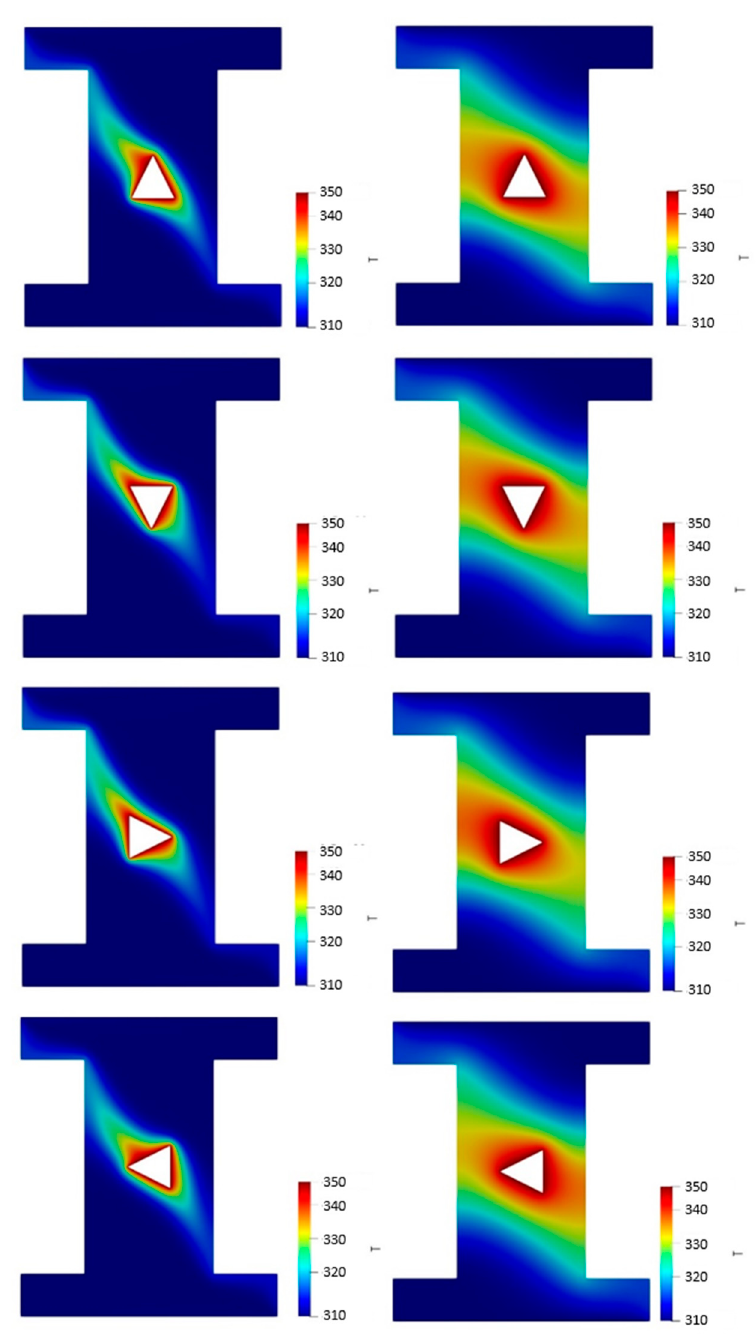
Figure 6. The temperature contours of the 4% vol. NF in sand-based ( left column ) and metallic powder-based cavities ( right column ) with different orientations of the hot block .